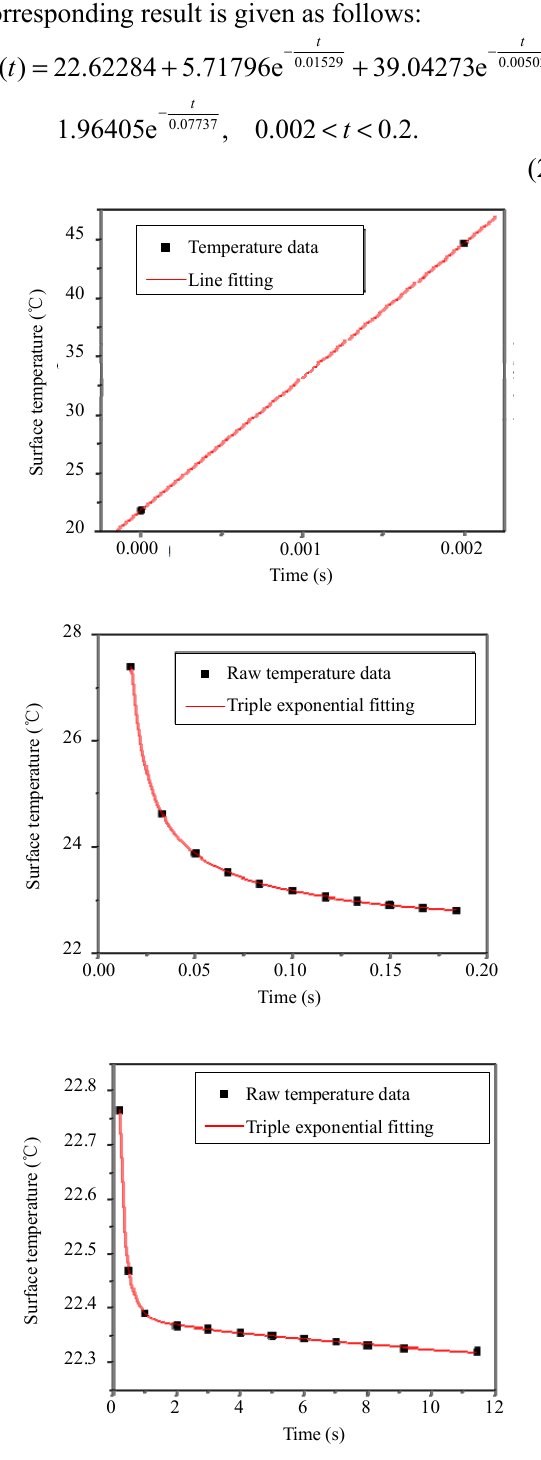
Fig. 5 Subsection fitting results of the surface temperature